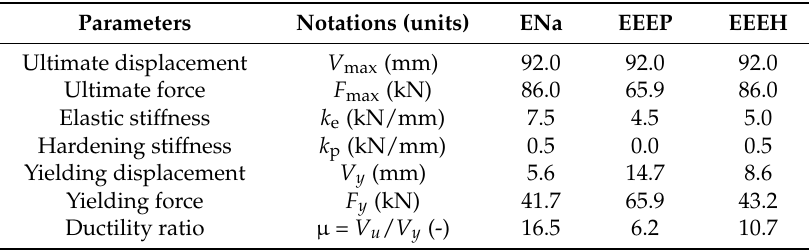
Table 1. Wall A test results and interpretation according to EN 12512 method (ENa) [24], equivalent Elastic–Plastic Energy method (EEEP) [33] and Equivalent-Energy Method with Post-Elastic hardening branch (EEEH) [20].